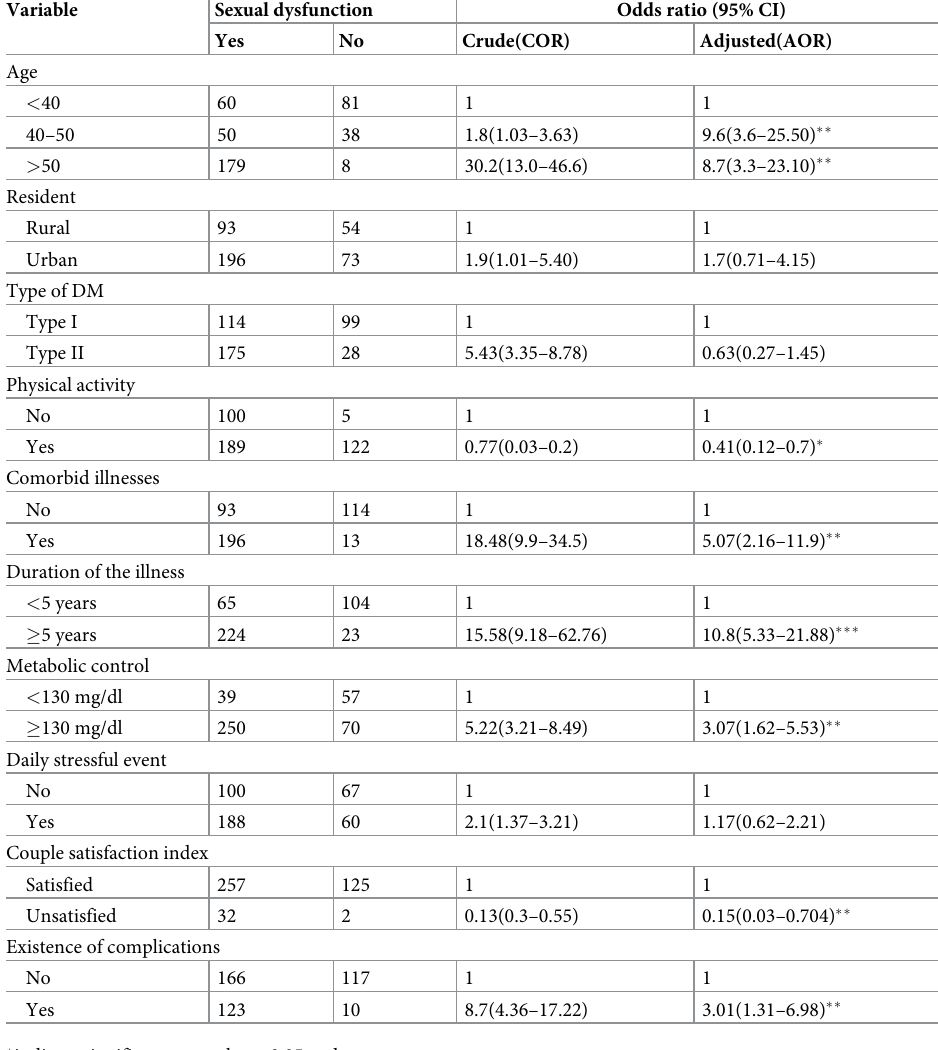
Table 2. Factors associated with SD among men patients with diabetes at the three hospitals of Northwest Amhara region, Ethiopia from February 20–April 15, 2020 (n =